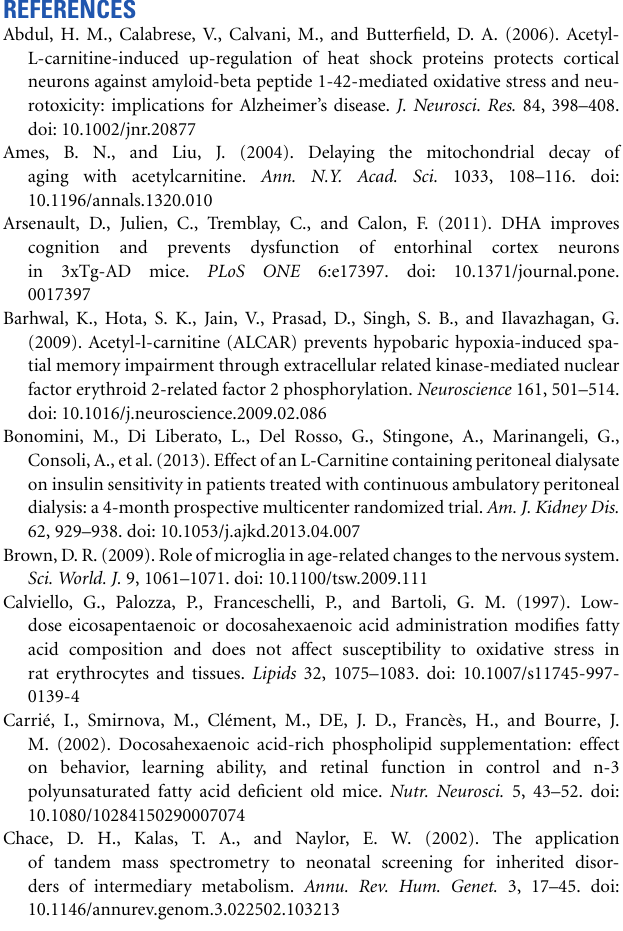
Supplementary Figure 1 | The histograms show the phagocytosing Iba1 + cell number of the Dentate Gyrus, CA3, and CA1 in n-3 PUFA, NAÏVE, and OLIVE OIL